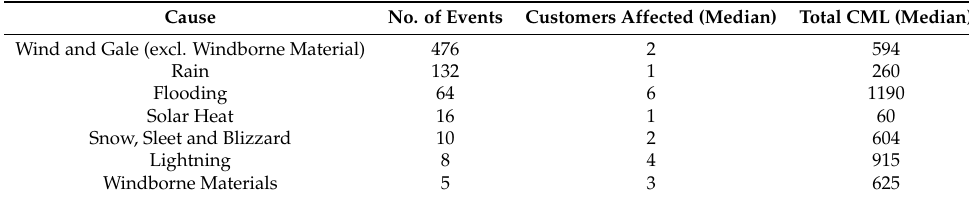
Table 2. LV weather related